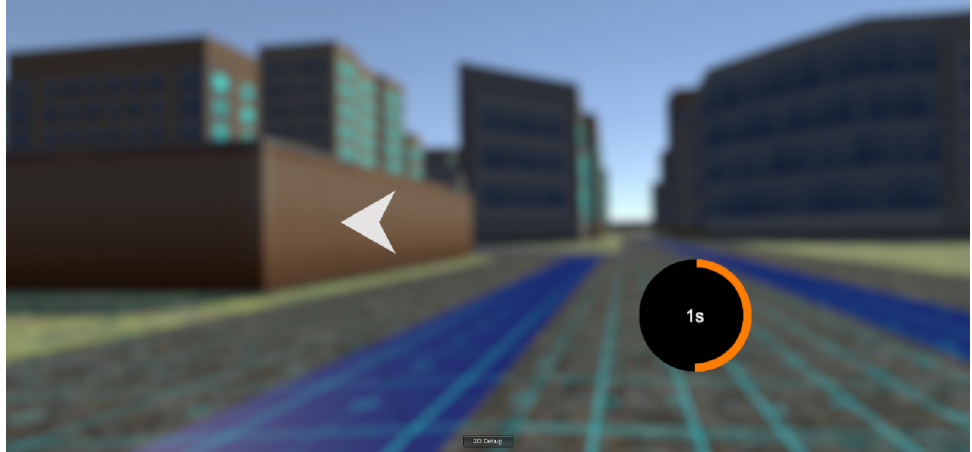
Figure 2. The visual cues we used in the ISL to improve the user experience of the semi-Limited mechanism. A blur animation, a countdown icon, and an arrow indicating the moving direction are